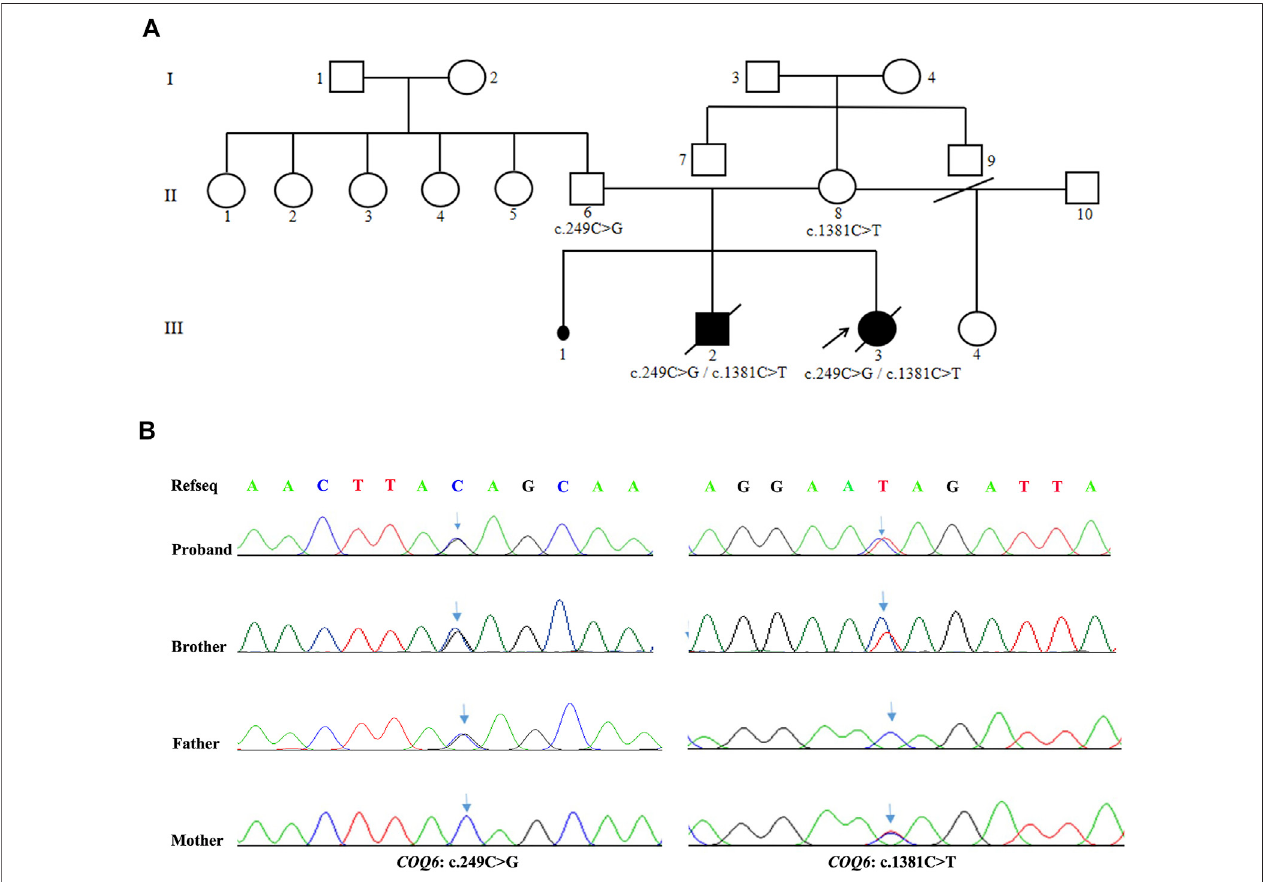
FIGURE 1 | Family pedigree and con fi rmation of the compound heterozygous variants of COQ6 . (A) Pedigree shows the cosegregation of COQ6 mutations in the family. The patient pointed by the arrow indicates the proband. Black symbols indicate clinically affected members, and open symbols represent unaffected individuals. (B) Validation of COQ6 variants in the family by Sanger sequencing, and the arrows represent sites of